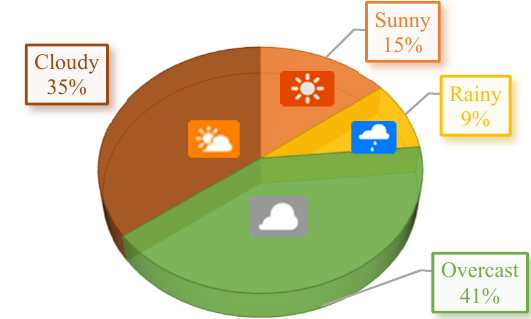
Figure 1. The location of the study area and its digital elevation model (DEM).